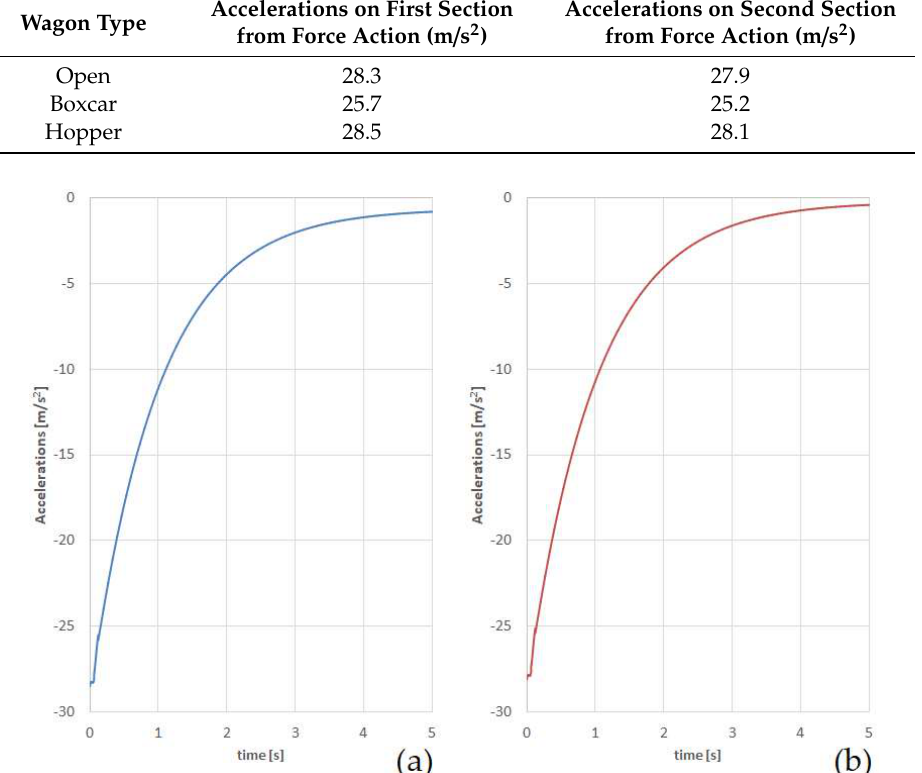
Figure 7. Accelerations on the carrying structure of the articulated open wagon: ( a ) first and ( b ) second sections of the flat wagon from longitudinal force.